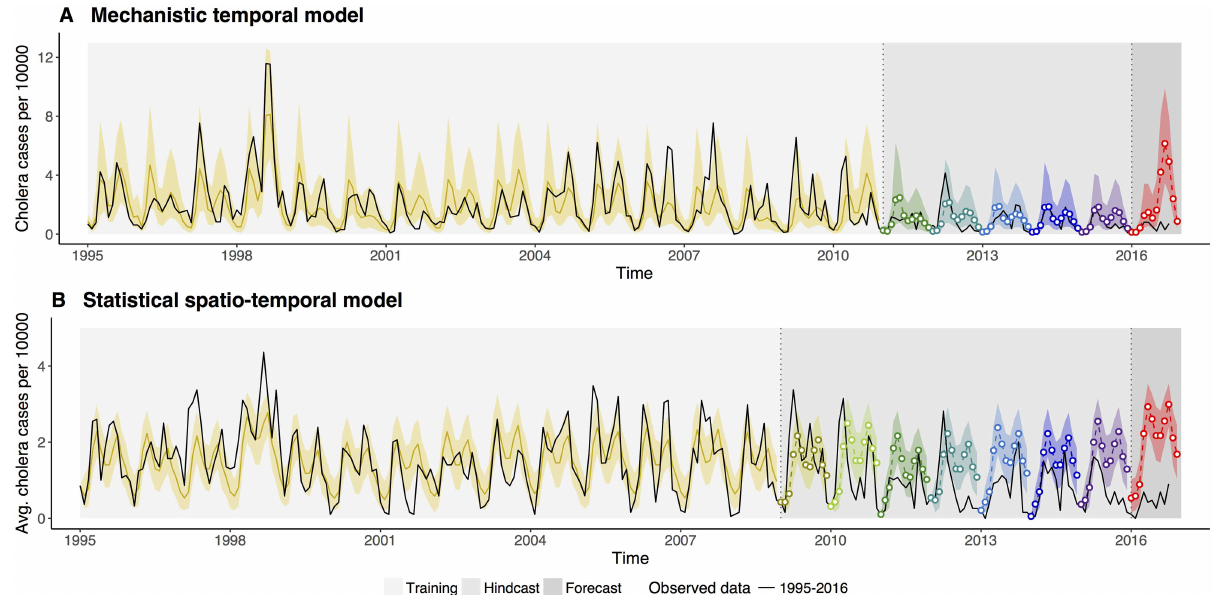
Fig 2. Comparison of simulated and predicted monthly cases with those reported for Dhaka, Bangladesh. The observedcases per 10000 individualsare shown in black for the core of the city (A) and for the averageof all thanas (for core and periphery,(B)). The median of 1000 simulations is shown in dark yellow, with the 10–90%confidenceintervals(C.I.) in the shadedlighter color. Simulations of the predicted out-of-fit data are shown in different colors starting in 2011 in (A) and in 2009 in (B), with the median for each month in open circles, and their respectiveC.I. envelopein a shadedlighter color. Vertical dotted lines and corresponding background shadingindicatethree different kinds of model simulations and “predictions”: for the initial period(white background), the model is simulatedfrom 1995 forward. Thus, the comparisonto data is not based on the typical next-step (next-month) predictionfor which it is somewhat trivial for most models to capture the fitted data. These simulations span more than a decade. The second period(light gray background) shows predictionsfor out-of-fit years, with simulations starting in Januaryand spanningthe wholeyear. We refer to these predictions that cover windowsof time in the past, as hindcasts.Finally, the last periodis for the current year and constitutes a true forecast (for the upcomingfall season)which we implemented in ‘real time’ and comparedto observations once the cholera season had